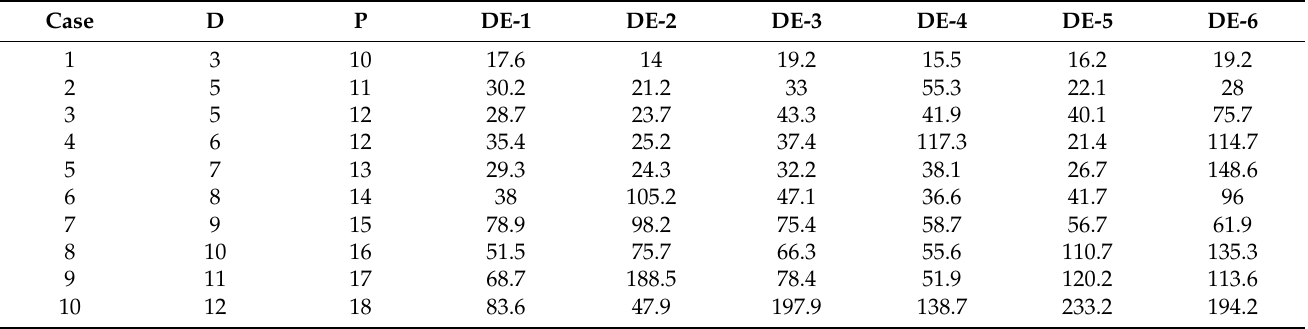
Table 21. Average number of generations for six discrete DE algorithms with population size NP = 50; r D = r P =